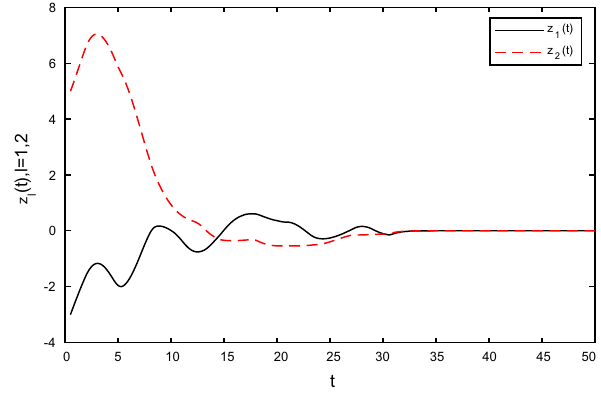
Fig. 3 The evolutions of z 1 ( t ) and z 2 ( t ) with 𝜏 ( t ) = 𝛿 ( t ) = 0.5 ( 1 + sin2 t )